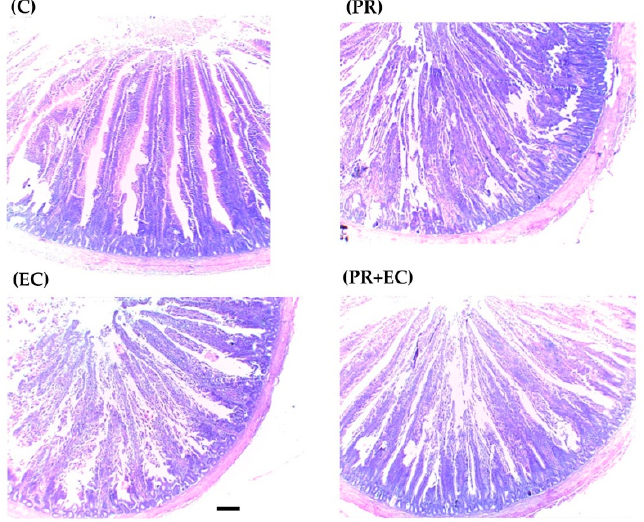
Figure 2. Histomorphological images of small intestines of laying hens (Scale bar 100 µ m): ( C ) laying hens received a basal diet and injected with saline (control); ( EC ) laying hens received a basal diet and injected with E. coli (10 7 colonies / hen); ( PR + EC ) laying hens received a basal diet supplemented with propolis at 1 g / kg feed and injected with E. coli (10 7 colonies / hen) and ( PR ) laying hens received a basal diet supplemented with propolis at 1 g / kg feed and injected with